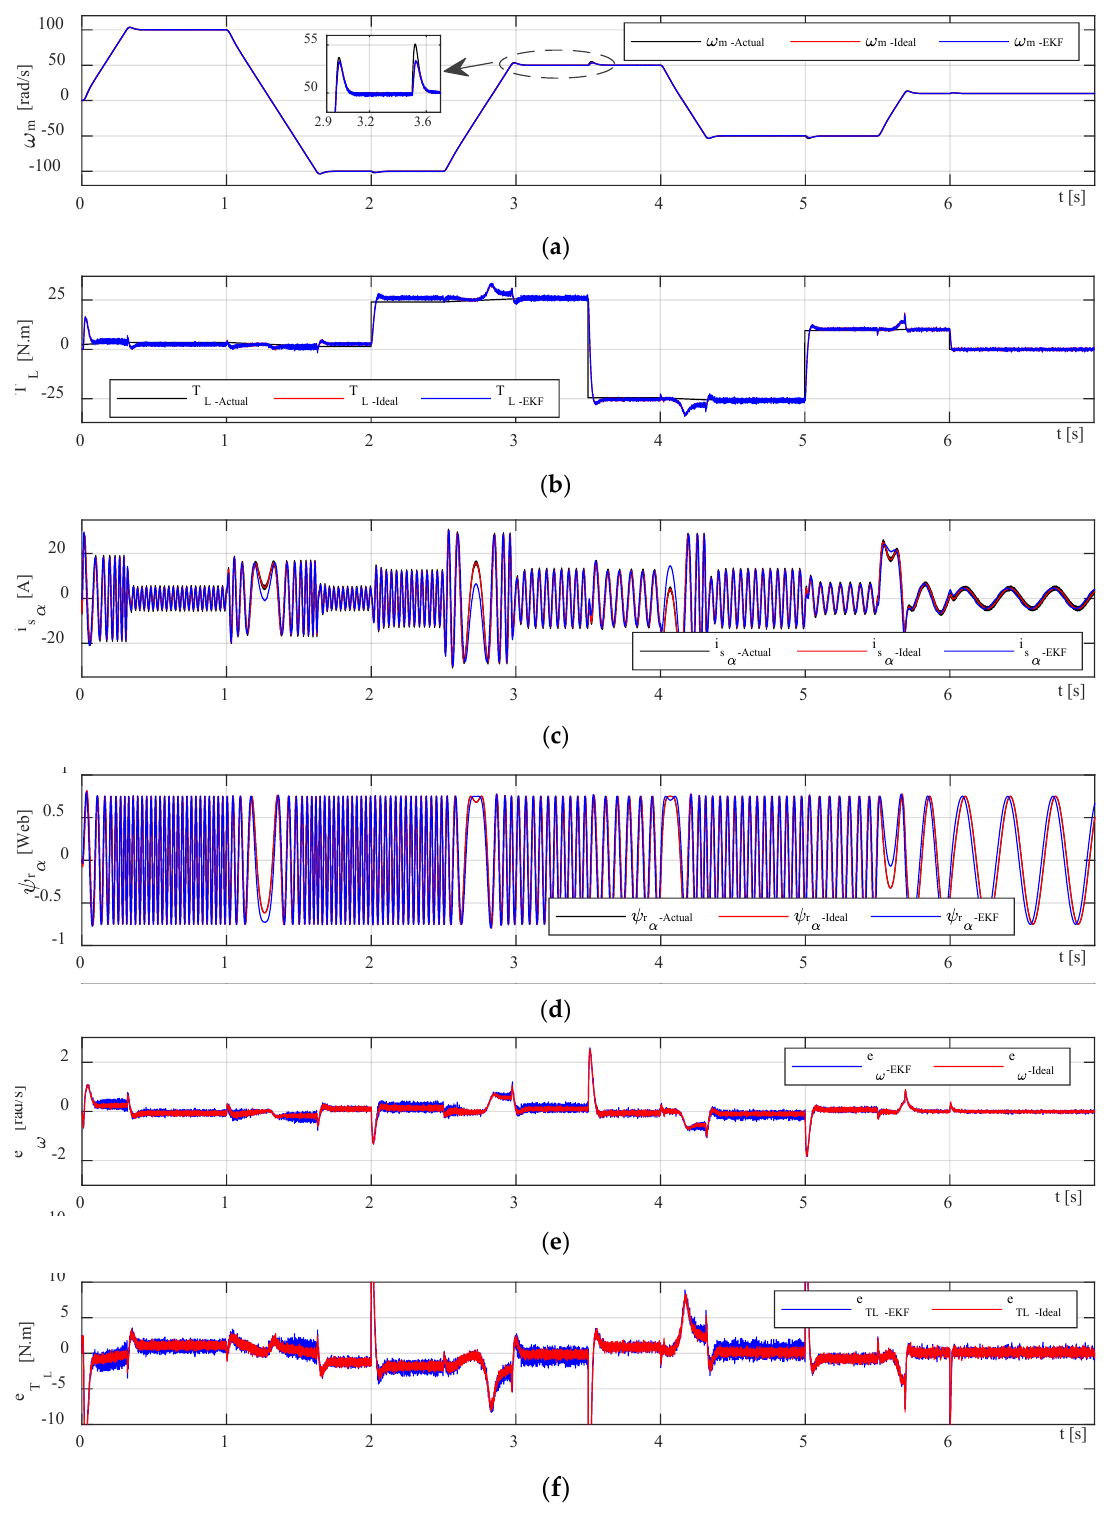
Figure 7. The EKF algorithm estimation results for ( a ) speed, ( b ) load torque, ( c ) current, ( d ) rotor flux, ( e )speed error, and ( f ) load torque error of the speed-sensorless IM drive. Table 2. different operation modes of the proposed IM drive system.